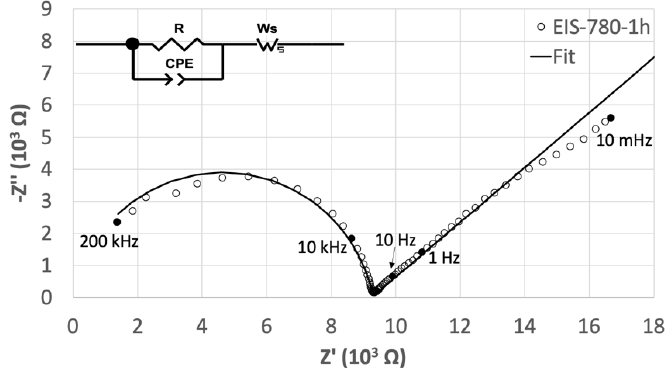
Figure 2. Nyquist plot of EIS measured at 780 °C (circles) and fit (solid line). The inset shows a schematic model of the equivalent electric circuit used for fitting.